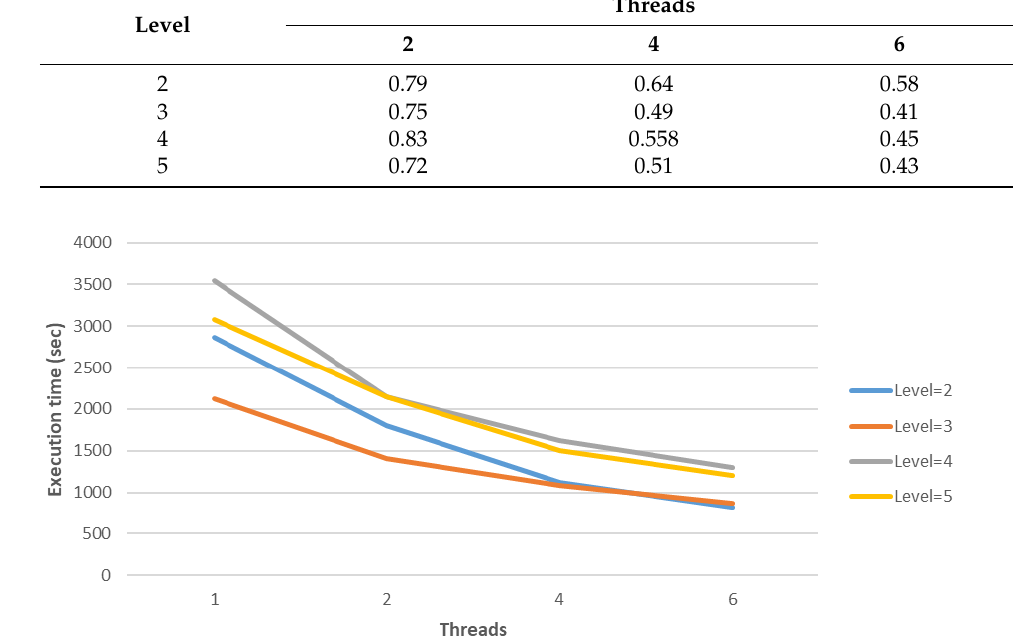
Figure 4. Execution times (in seconds) of parallel V cycle of AGAMG in combination with deflation technique and MGenFAspI with droptol = 0 and l fill = 2 for 3D Poisson model problem with nx = 70.